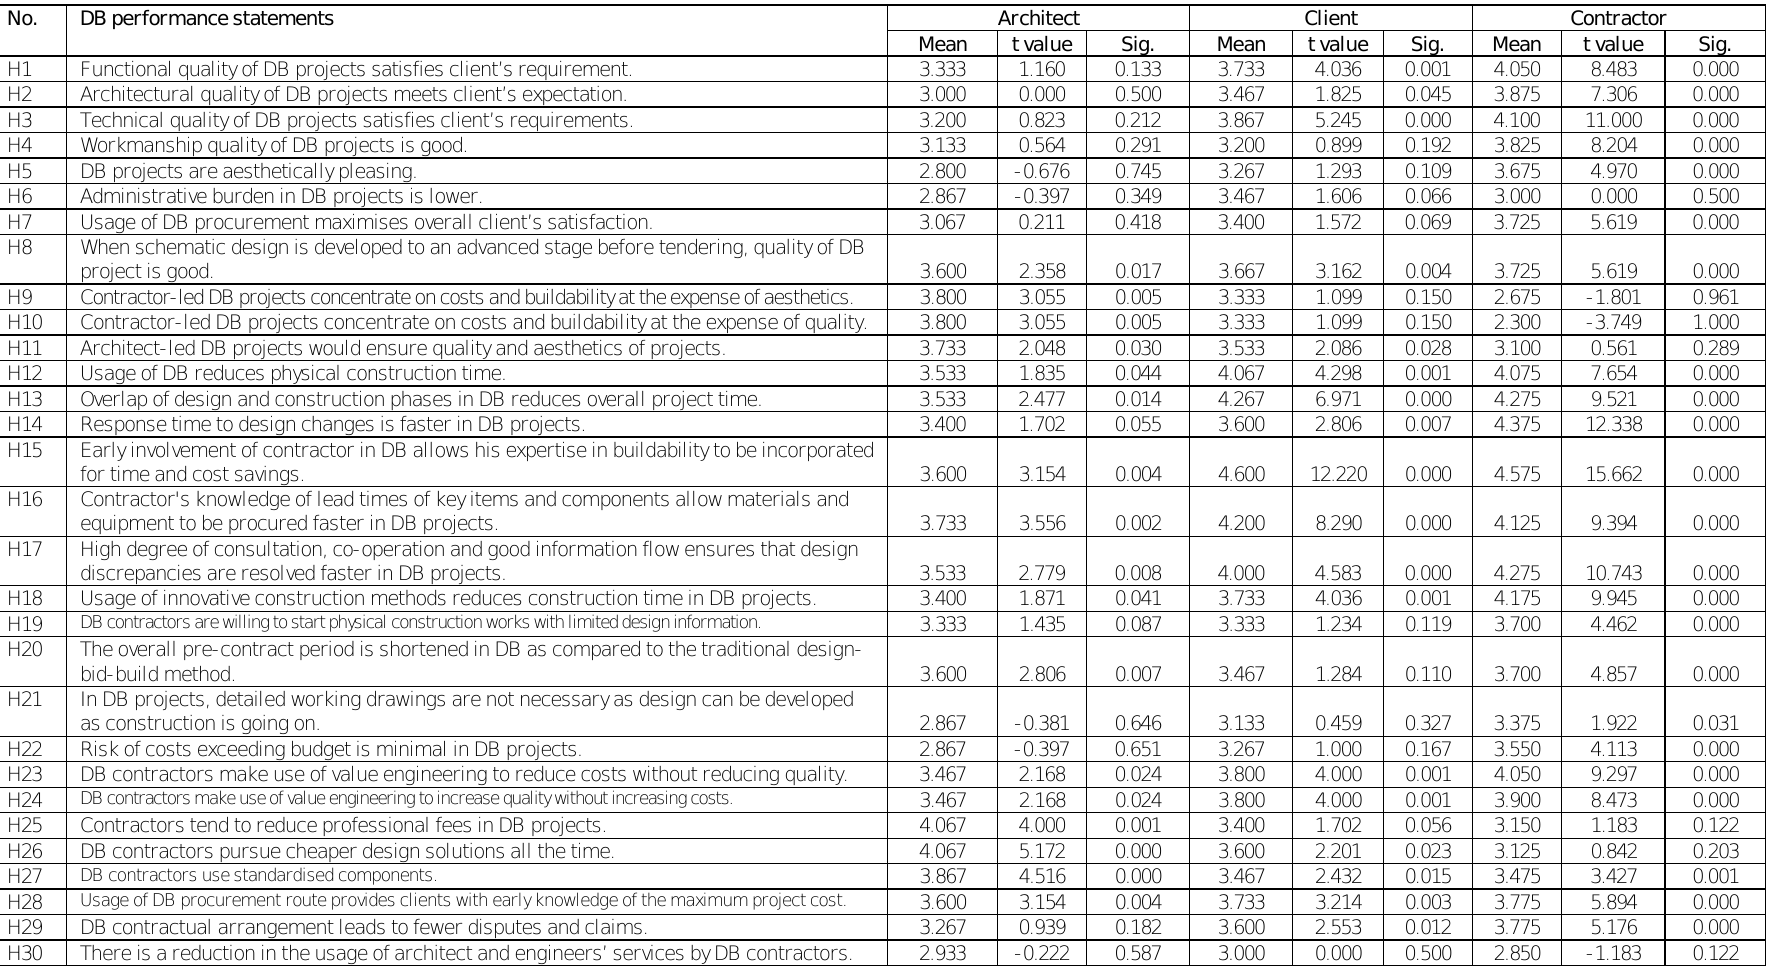
Table 1: Statistical results of architects, clients and contractors’